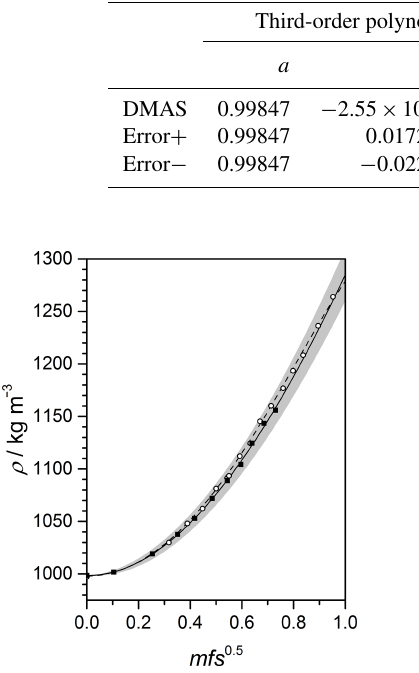
Figure 9. DMAS density ( ρ) dependence on mass fraction (mfs 0 . 5 ) of solute. Symbols: black squares – measured densities, this work; solid line – third-order polynomial fit of measured ρ values; grey shaded area – evaluated uncertainty of the density parameterisation (calculated as discussed in the main text); open circles – measured densities from Clegg et al. (2013); dashed line – densities from the apparent molar volumes fitting by Clegg et al.